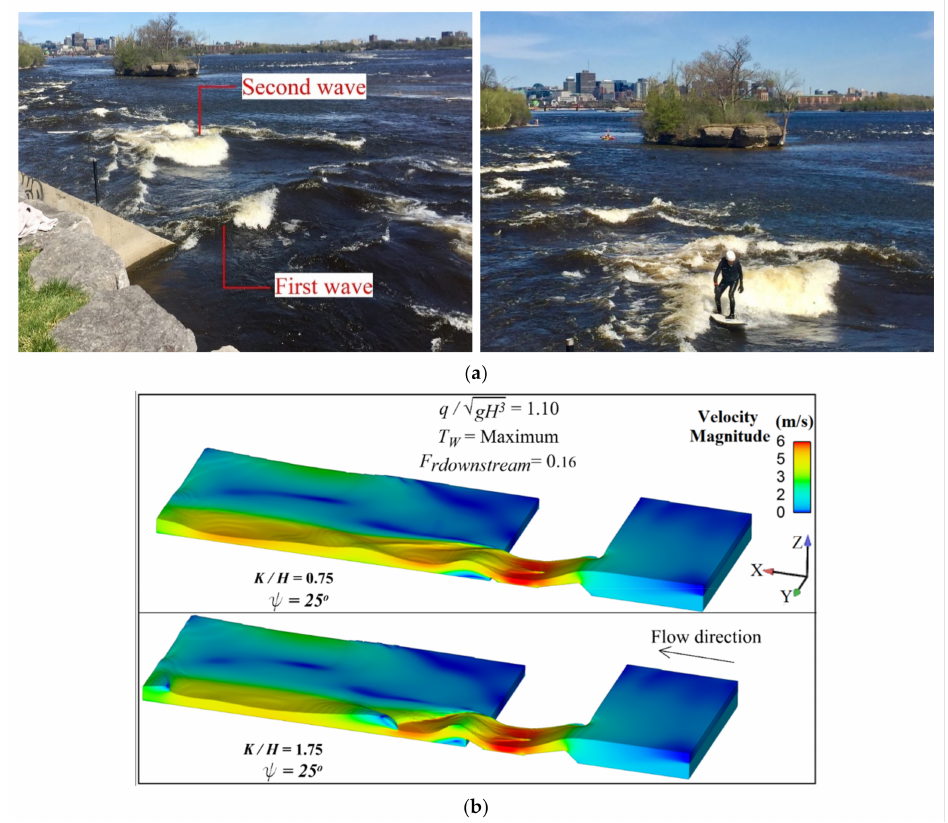
Figure 10. Flow field of river surf waves: ( a ) wave train in Ottawa river, ( b ) effect of kicker length on velocity field—cutaway view down the channel